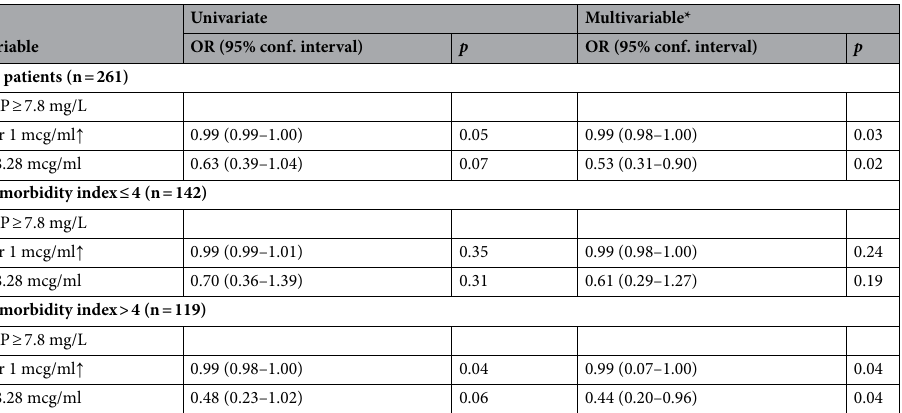
Table 3. Associations between serum adiponectin levels and inflammation defined as CRP ≥ 7.8 mg/L (above of the median of its distribution) in the whole study population and in subgroups of patients categorized by comorbidity index according to univariate and multivariable logistic regression analyses. CRP, C-reactive protein; OR, odds ratio; DM, diabetes mellitus. *Adjusted for age, sex, DM status, dialysis vintage, residual renal function, comorbidity index, smoking and Kt/V.